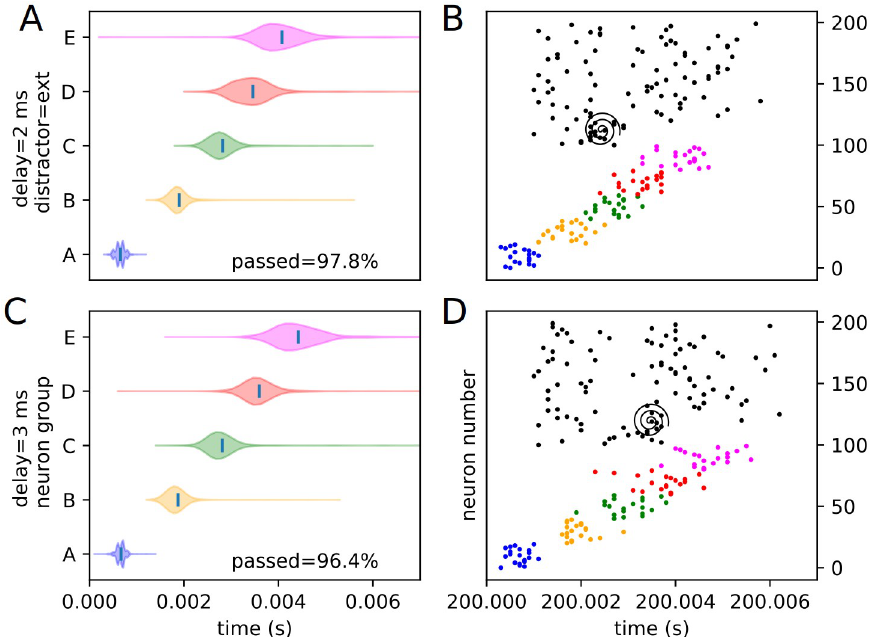
Fig 11. Experimental peak distributions for late external distractors. Violin plots (densities estimated with a 50 point Gaussian kernel) of the peak times for the second two temporal variants of external distraction, with listed percentages of trials passing veto. A raster plot of an example distracted recall is also included. The spiral indicates the location of the distractor. (A) Violin plot for external distractor with 2 ms delay. (B) Example replay for external distractor with 2 ms delay. (C) Violin plot for external distractor with 3 ms delay. (D) Example replay for external distractor with 3 ms delay.